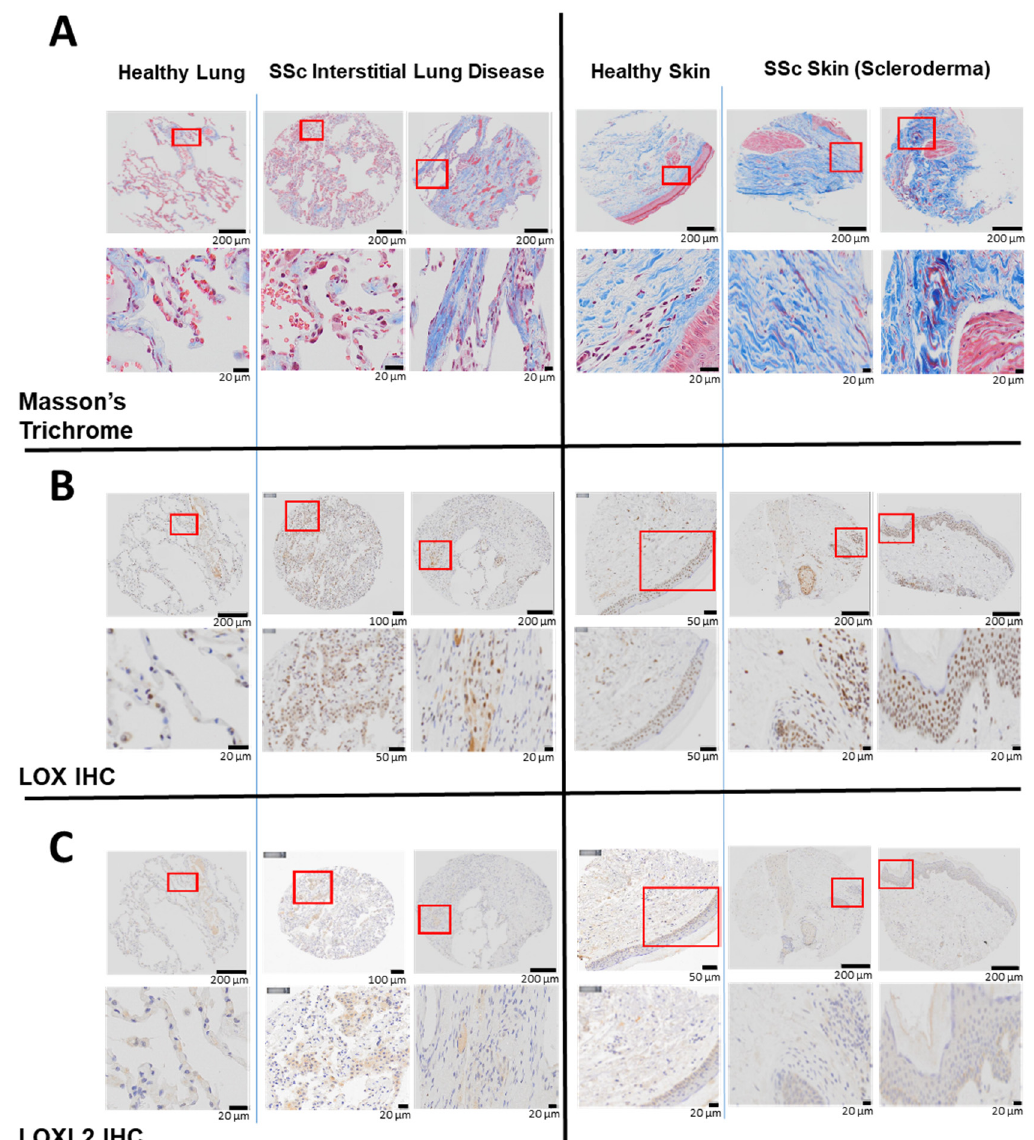
Figure 1. Elevated LOX and LOXL2 and collagen expression in the lung and skin of human patients with SSc. In lung tissues, LOX and LOXL2 was mainly expressed by macrophages and to a lesser extent by the pneumocytes, and endothelial cells of the lung vessels. In skin, LOX and LOXL2 was mostly expressed by the keratinocytes and epithelial cells within the sebaceous glands and the hair follicles. Positive macrophages and fibroblasts can be seen as well. LOX can be seen highly ex- pressed in the nucleus and cytoplasm in comparison to a weaker signal of LOXL2 and more in the cytoplasm than the nucleus. ( A ) Masson’s Trichrome staining revealed higher expression of collagen in the lung biopsies from two patients with interstitial lung disease and SSc compared to a healthy human subject, and higher collagen expression in the skin biopsies from a separate group of two patients with scleroderma compared to normal skin from a healthy subject. ( B ) Immunohistochem- istry (IHC) staining using a specific primary antibody against human native LOX revealed higher expression of LOX in the above lung and skin biopsies compared to the respective healthy subjects. ( C ) Immunohistochemistry (IHC) staining using a specific primary antibody against human native LOXL2 revealed higher LOXL2 expression in the lung biopsies from above SSc patients compared to a healthy human subject. LOXL2 expression in the skin is minimal in both the SSc patients and the healthy human subject.